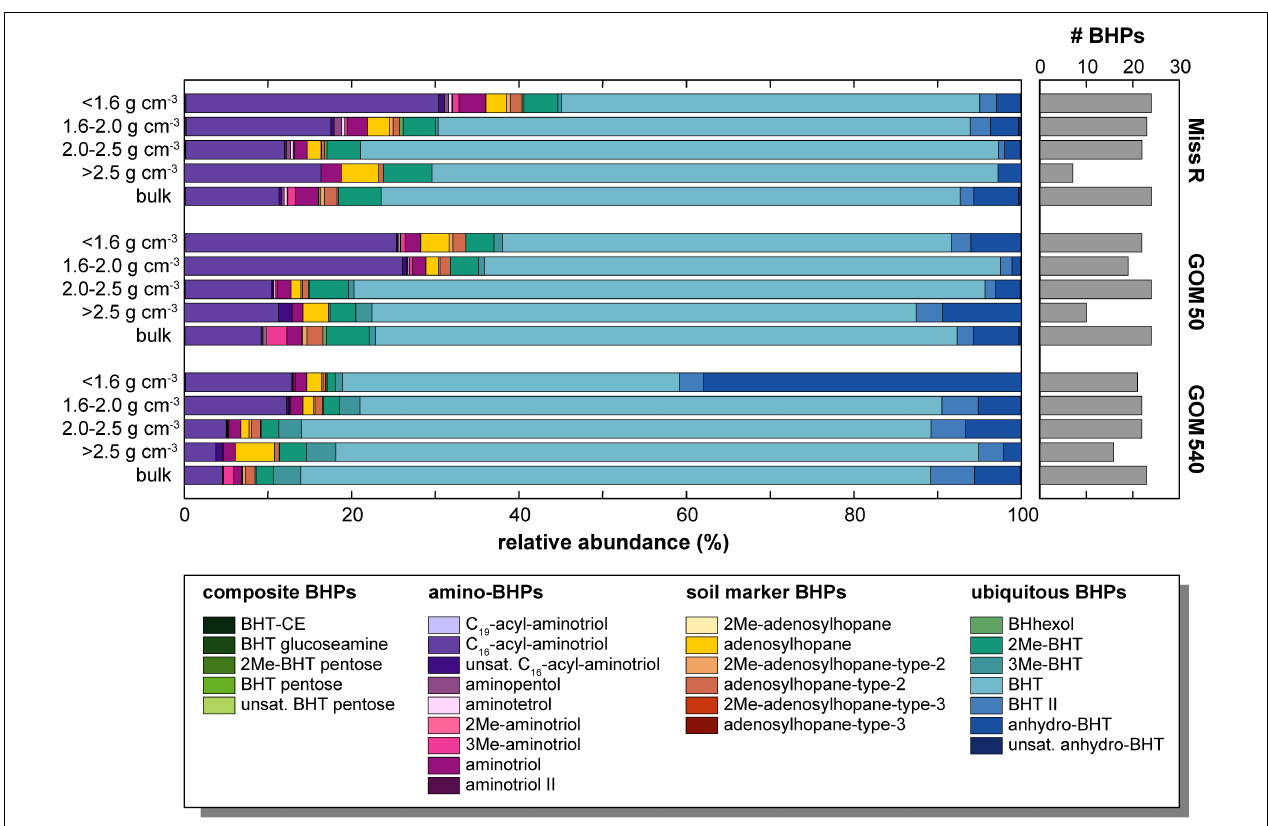
FIGURE 3 | Relative abundance and structural diversity of BHPs in density fractions and bulk sediment samples along the Miss R – GOM transect. Note that relative abundances < 1% are not well resolved graphically, we refer to Supplementary Table S1 for